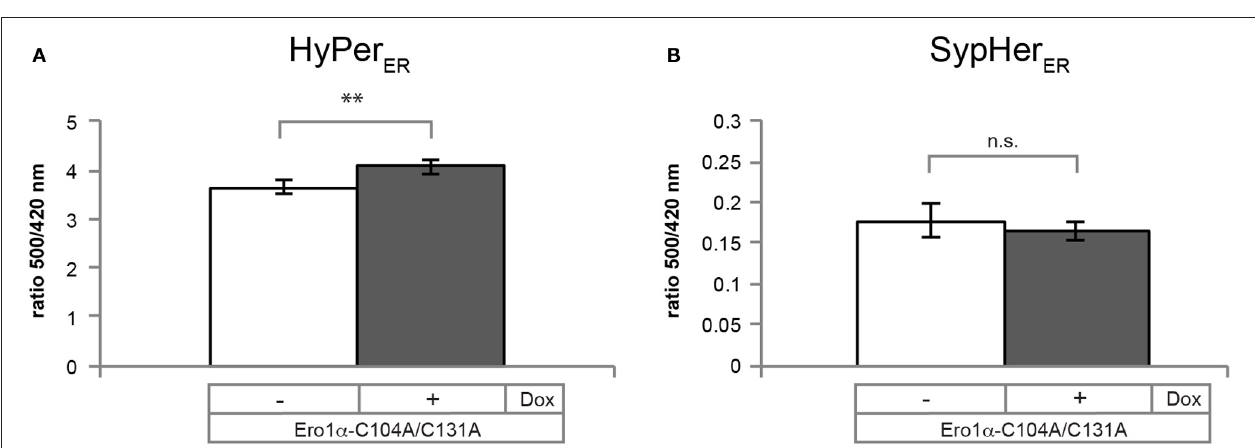
cells stably transfected with SypHer ER as in Figure 6 . Note the lack of redox-dependent ratiometric behavior and the decreased fluorescence intensity in the case of DTT-treated samples.